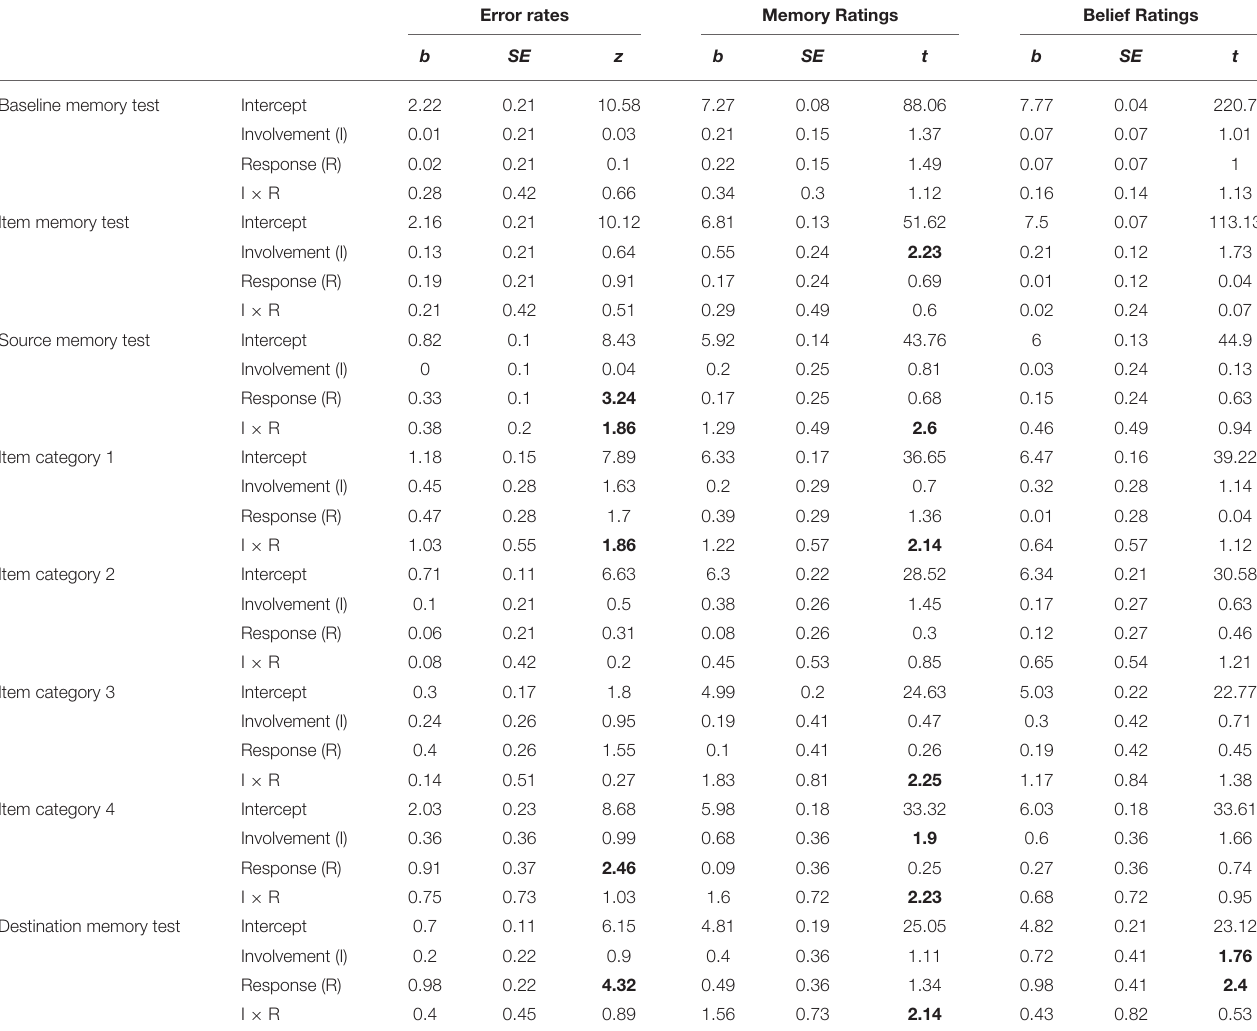
TABLE 2 | Statistical effect for memory